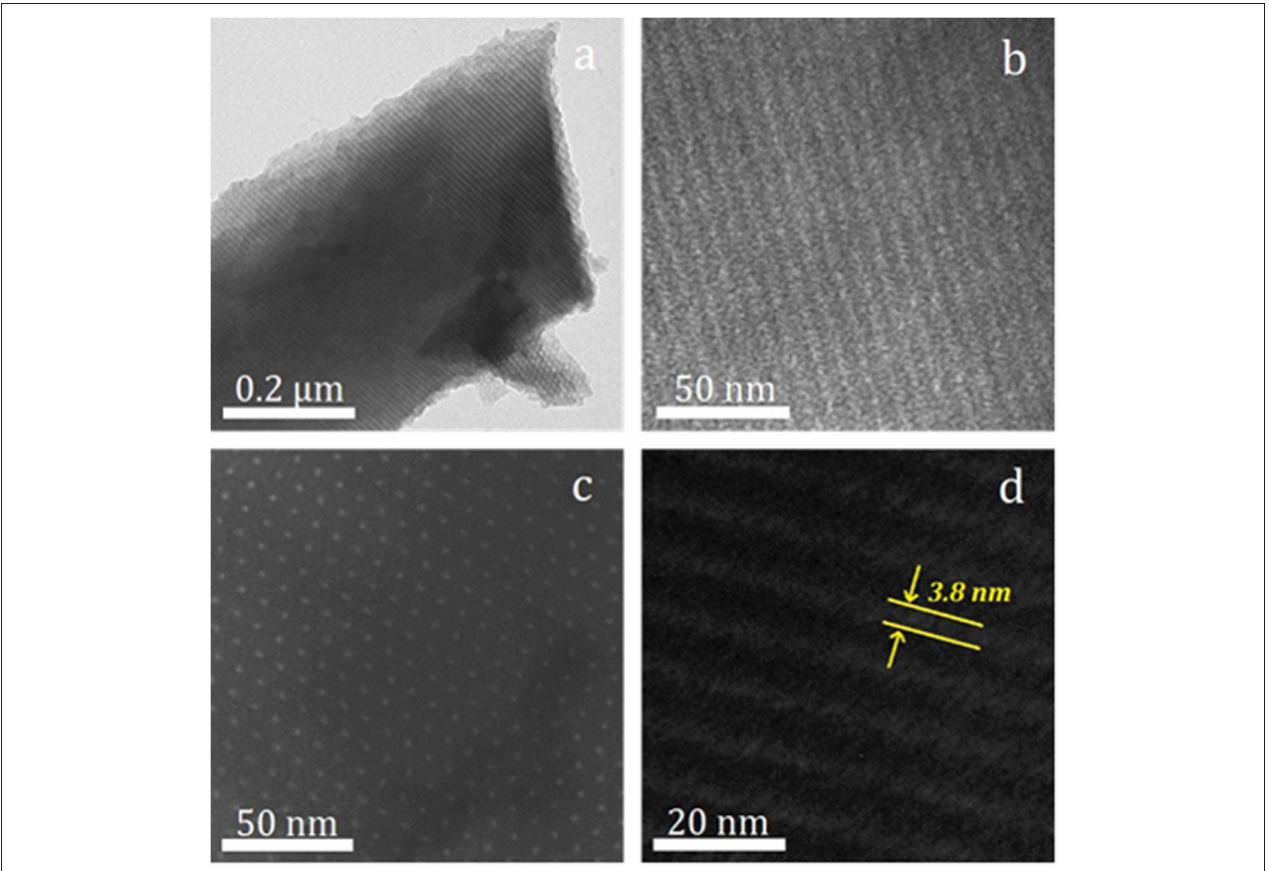
FIGURE 4 | Various magnification TEM images of NOMC − 0.3–750 viewed along [110] (a,b,d) and [001] (c) directions of hexagonal mesostructure.